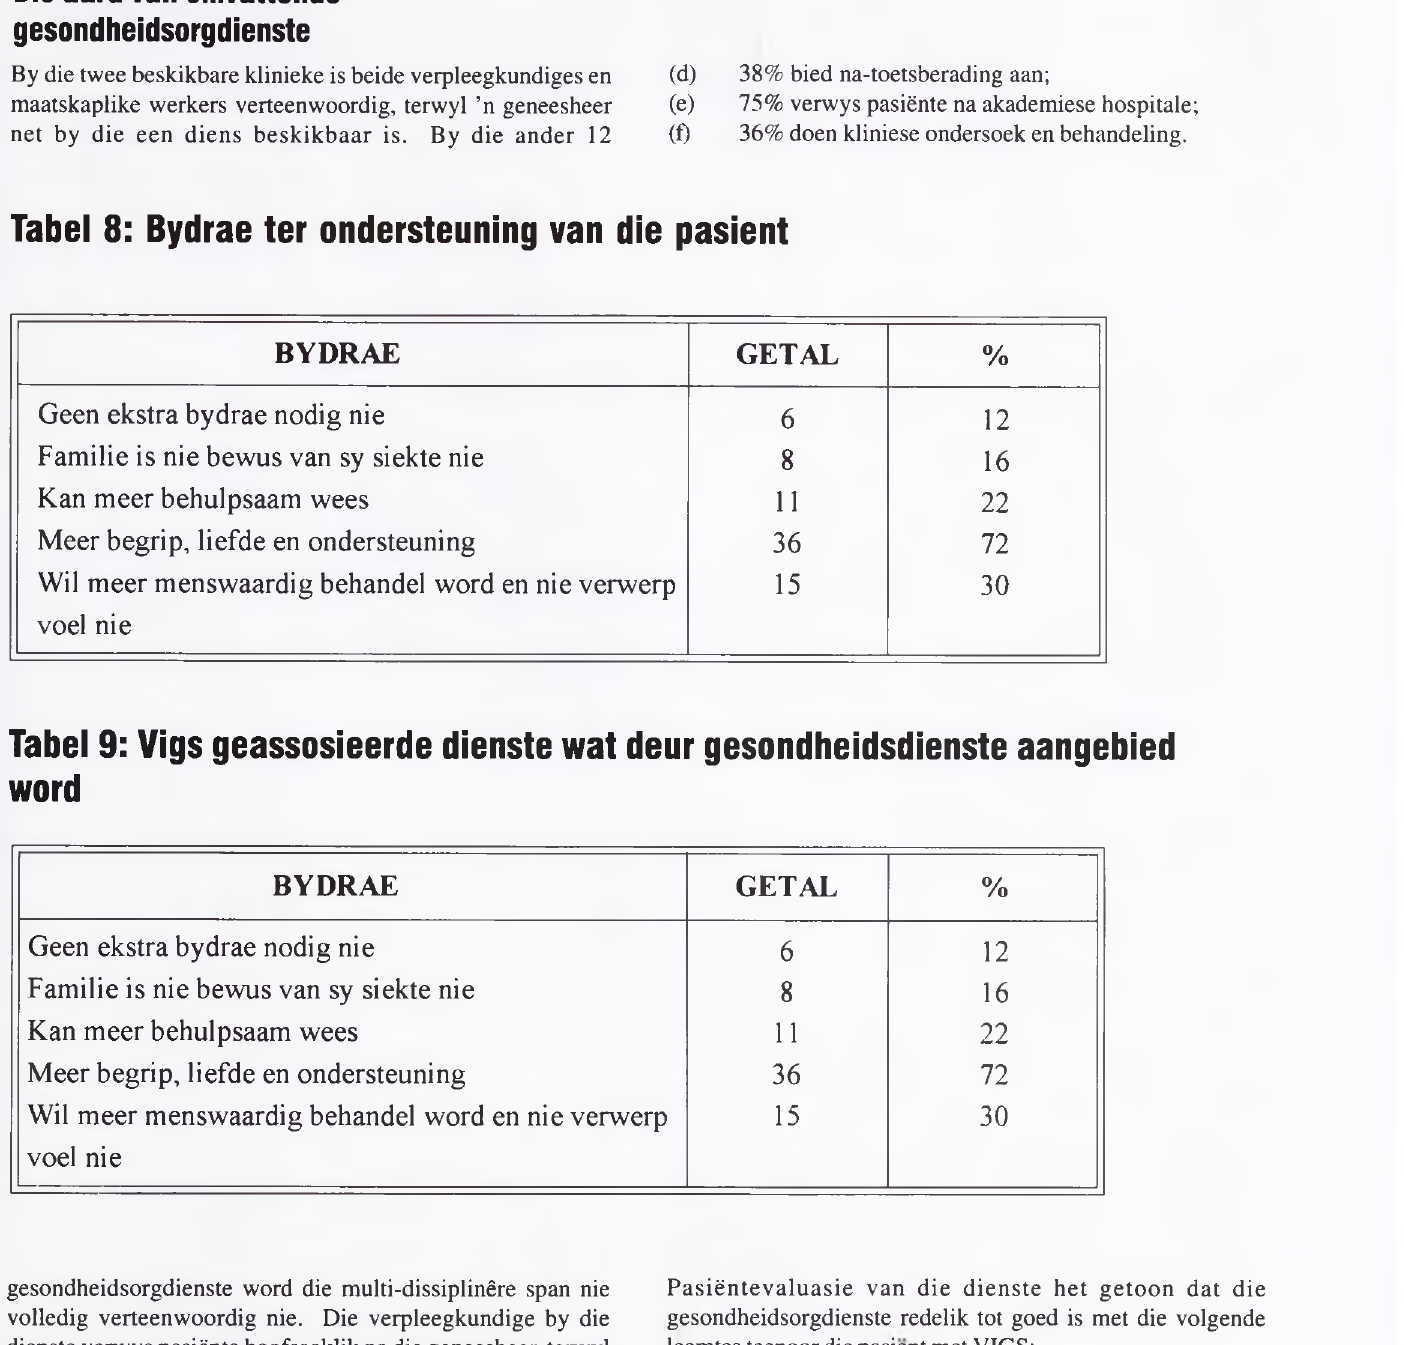
Tabel 8: Bydrae ter ondersteuning van die pasient